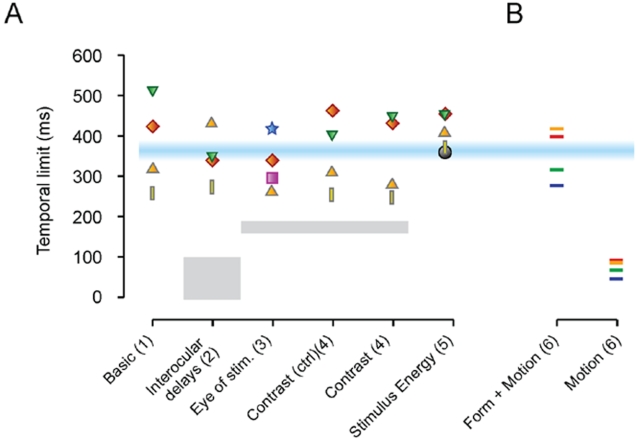
Overview of the obtained temporal limits.(A) Experiments 1-5. Individual subject data are denoted by different symbols. The label “Basic” refers to Experiment 1. Data in the Contrast (ctrl) condition was obtained with stimuli identical to those of experiment 1, which were interspersed with the stimuli of the contrast polarity experiment (“Contrast”, experiment 4). The numbers refer to the Experimental condition. The expected positions of the data points, if the experimental manipulations were effective, are indicated with grey boxes. The results show that the data cluster around a much higher temporal limit. The horizontal blue line represents the position of the estimated temporal limit, based on these experiments (363±11 ms, mean±s.e. over experiments 1-5). (B) Experiment 6. The Form+Motion conditions exhibited the same ∼350 ms temporal limits as Experment 1-5, while the Motion-only conditions did not.